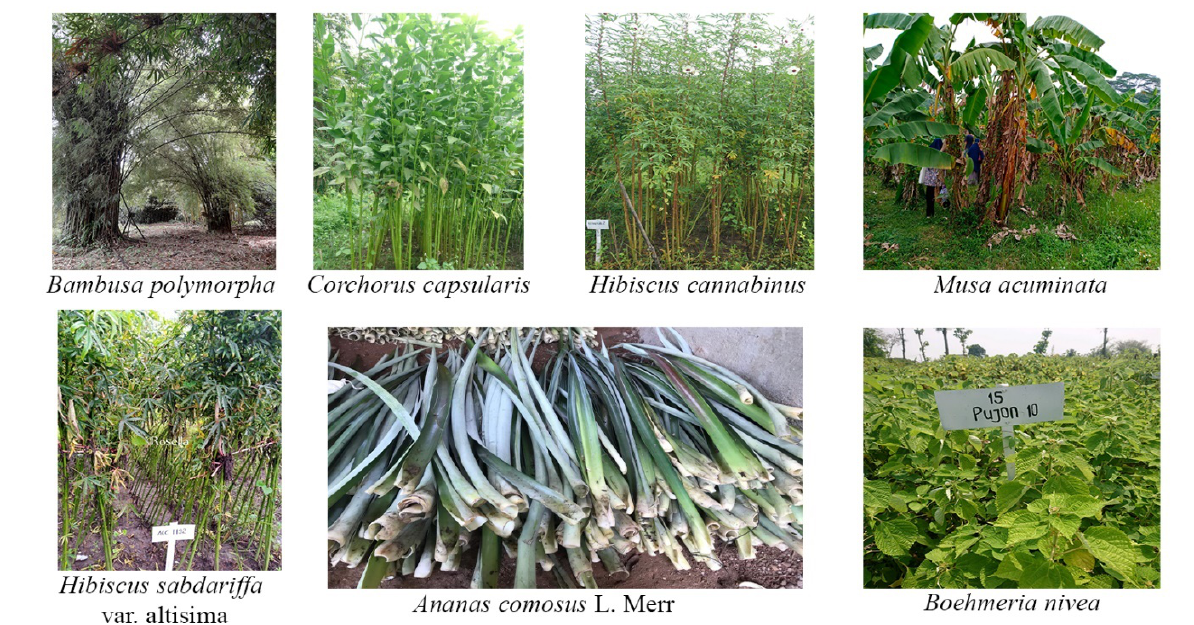
Figure 2. Some natural fiber resources (Pic courtesy authors